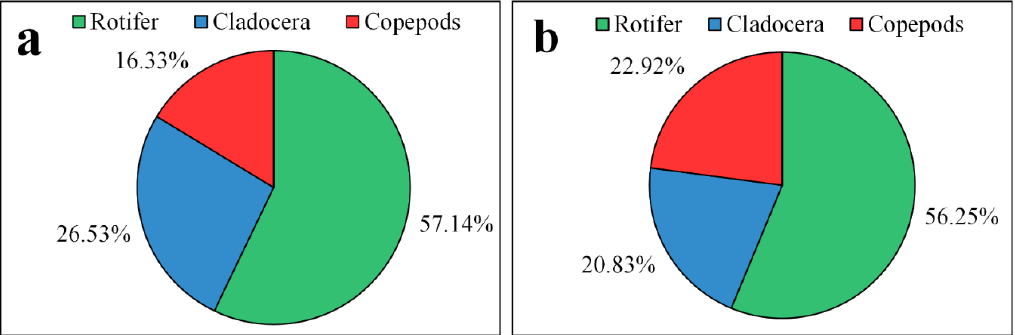
Figure 4. Percentage species composition of the zooplankton community in Lake Chen Yao ( a ) and Lake Feng Sha ( b ). Lake Feng Sha ( b